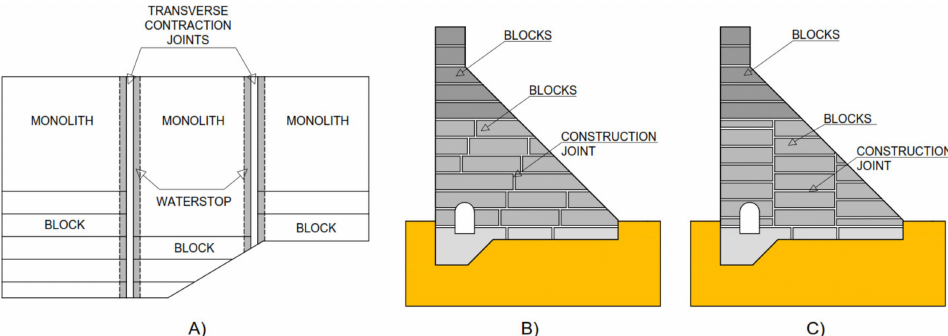
Figure 1. Waterstops, blocks, and joints of a concrete gravity dam: ( A ) waterstops between adjacent monoliths; ( B ) combination of long blocks and staggered joints; ( C ) combination of long blocks and vertical